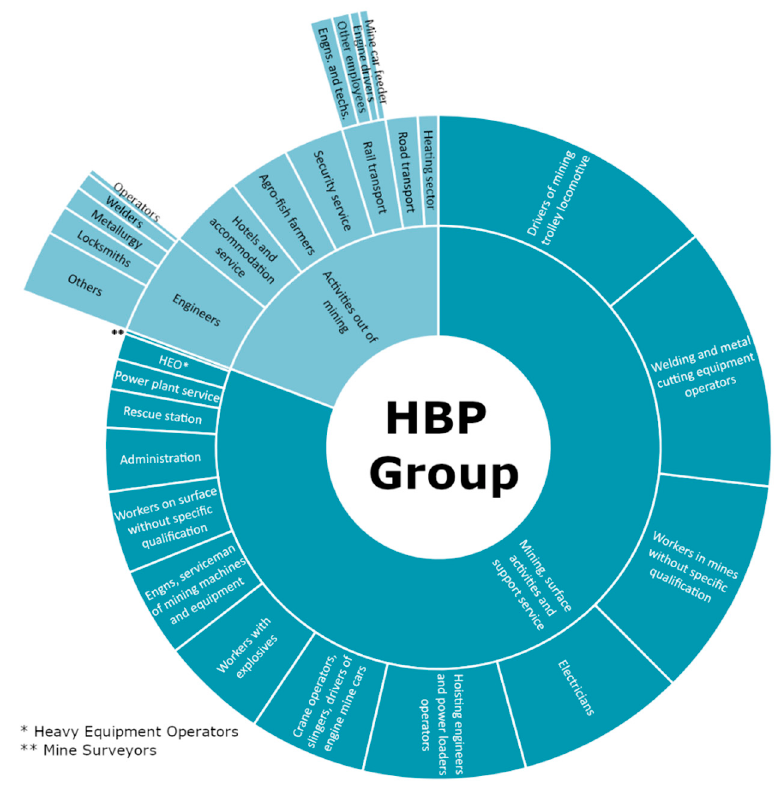
Figure 7. Shares of job profiles within the portfolio of the HBP group.